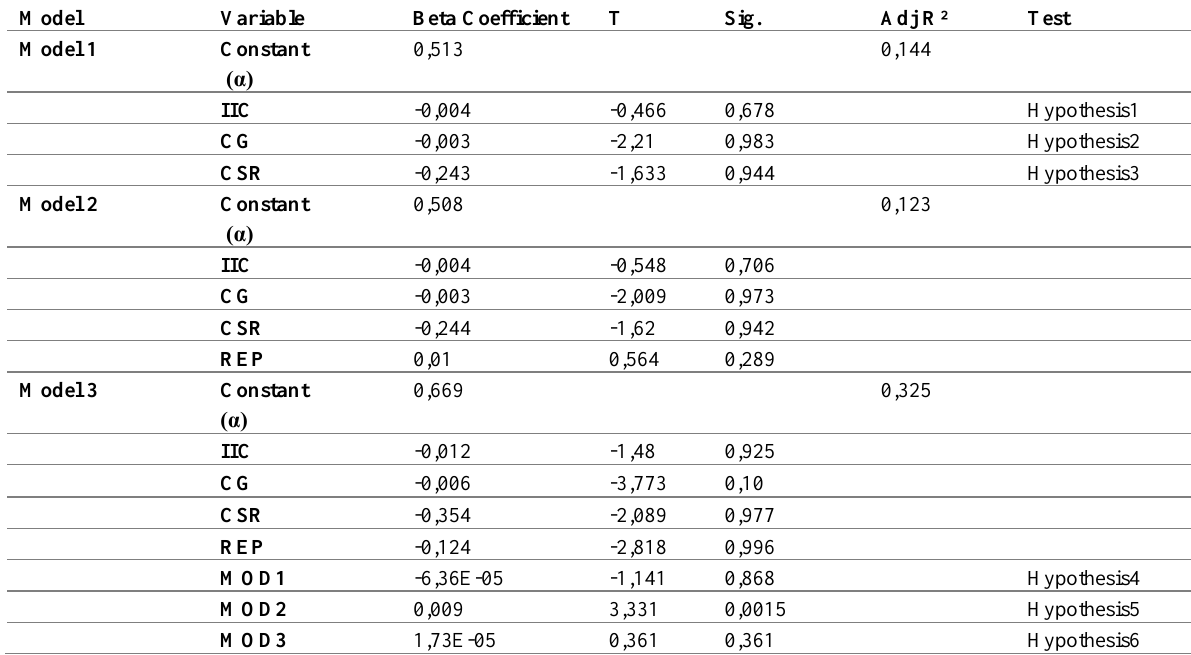
Table 2: Results of Regression